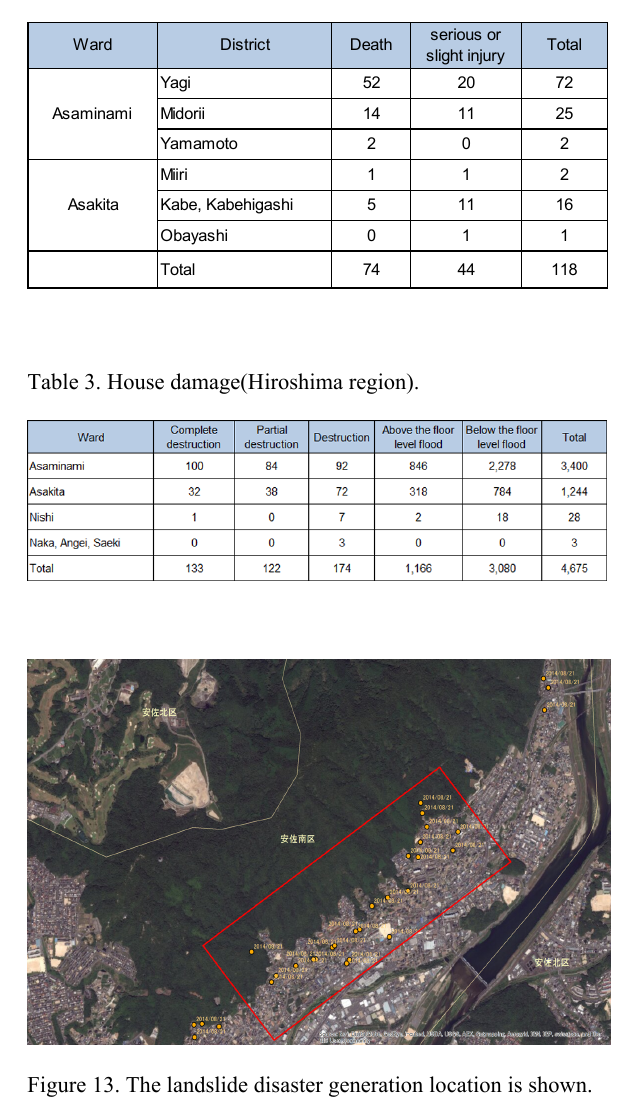
Table 2. Personal suffering (Hiroshima City region).